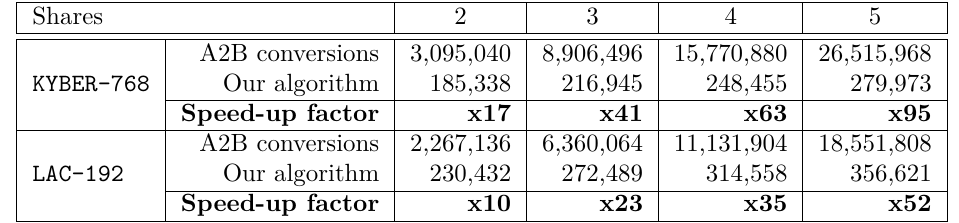
Table 2: Clock cycle counts for our ARM implementations of the masked comparison at 24 MHz for different parameter sets including randomness generation. All results are averaged over 100